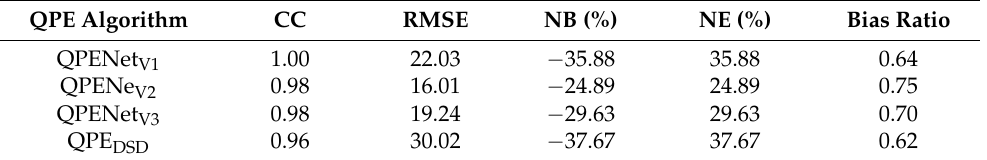
Table 8. The same as Table 5 except that the rainfall intensity is greater than or equal to 30 mm ( R ≥ 30 mm · h − 1